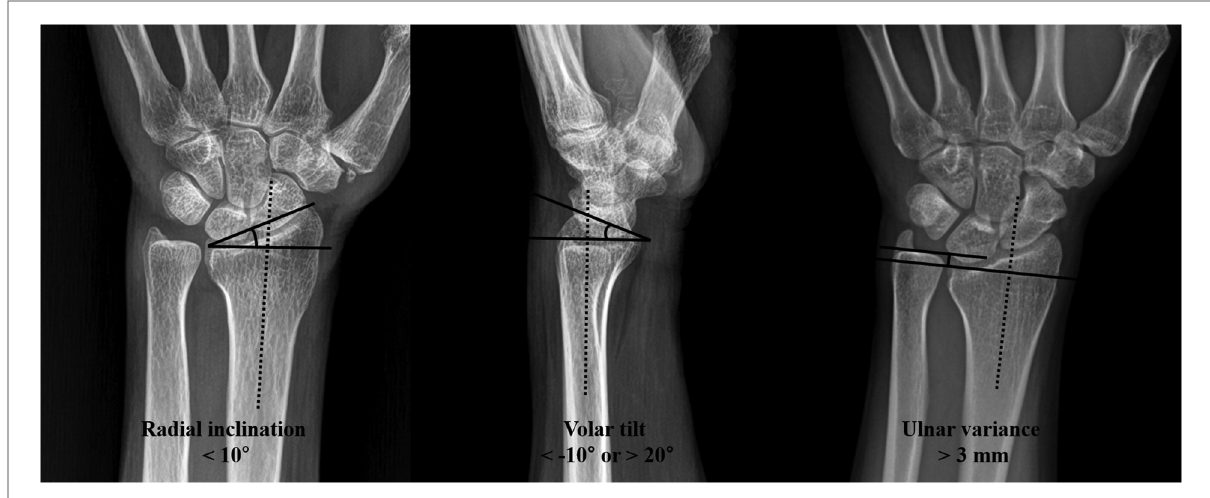
FIGURE 1 Radiological evaluation of the distal radius. If radial inclination, volar tilt, or ulnar variance of the patients fell within the range indicated below, they were included in the loss of reduction (LOR)